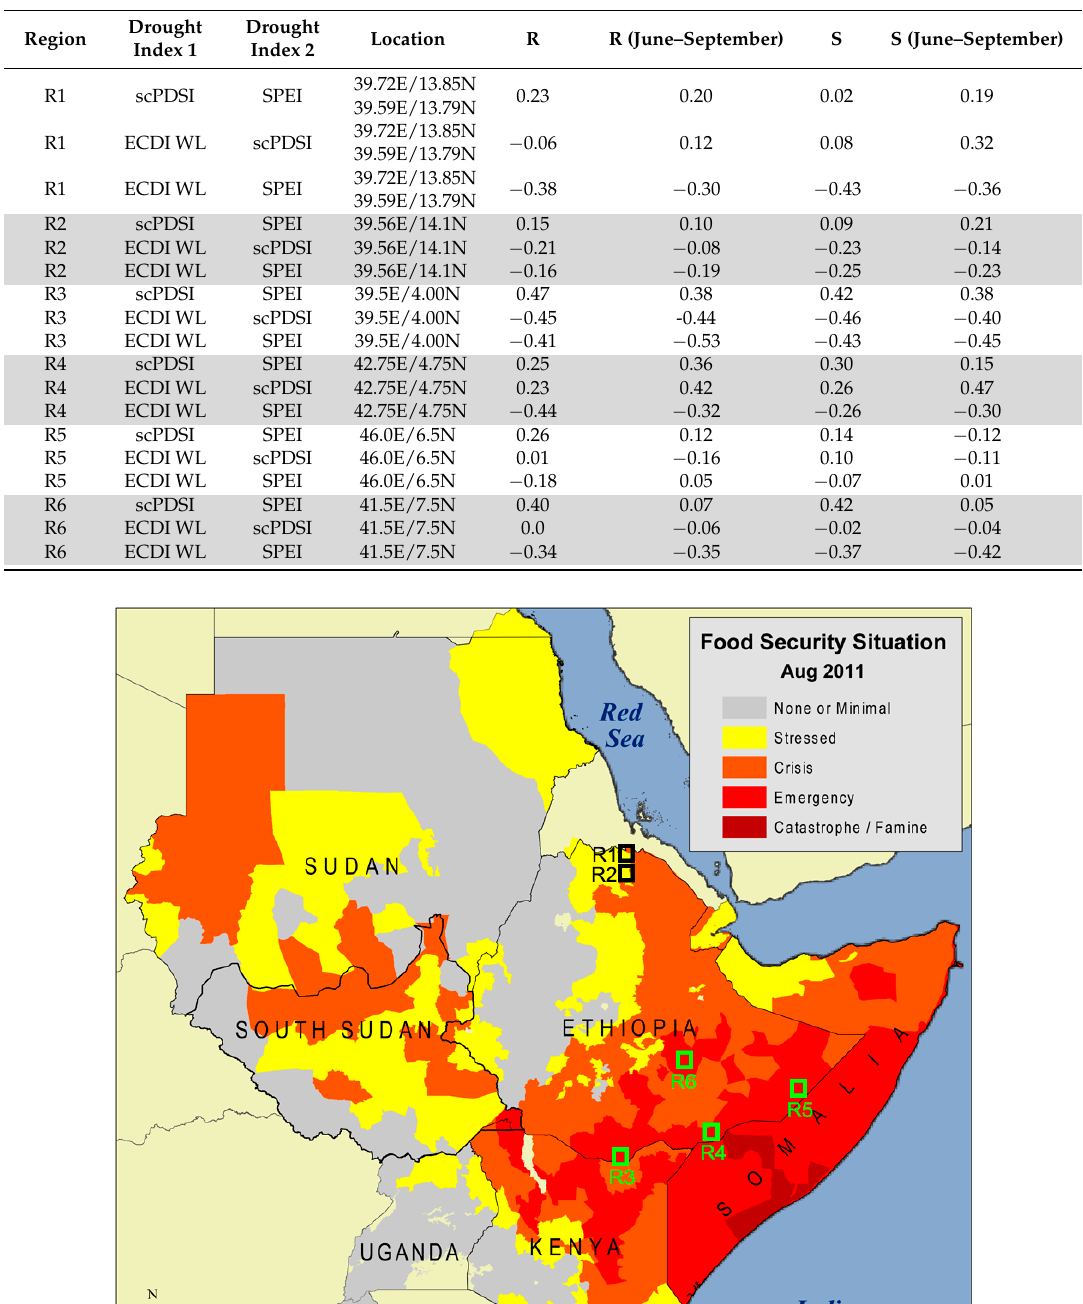
Table 2. Performance Metrics for the Tigray Region (WL = Warning Level, R = Pearson’s correlation coefficient, S = Spearman’s correlation coefficient); The two Coordinates in Region 1 (R1) cover the cities of Atsbi and Kinte Awelo, while R2 covers the city of Saesi Daedsaemba.